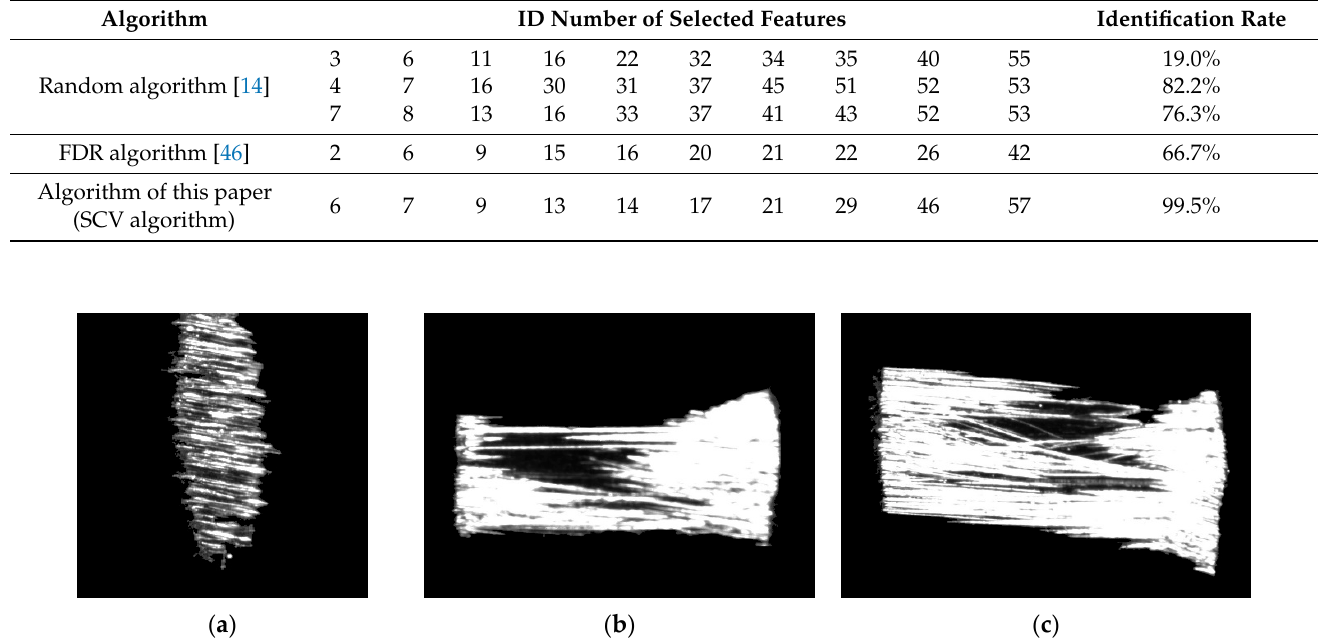
Table 2. Comparison of the identification rate of each feature selection algorithm.